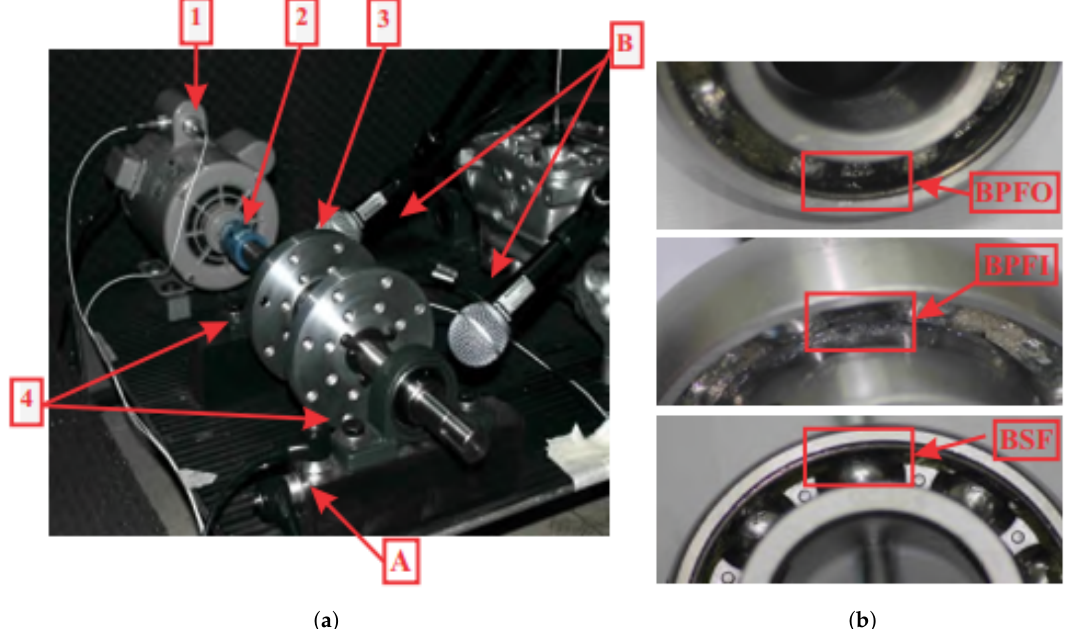
Figure 9. Experimental test rig ( left ): (1) motor driven; (2) rigid coupling; (3) drilling wheels; (4) bearing housing. sensor location: ( a ) accelerometers; and ( b ) microphones. Simulated OR, IR, and ball defects ( right ).